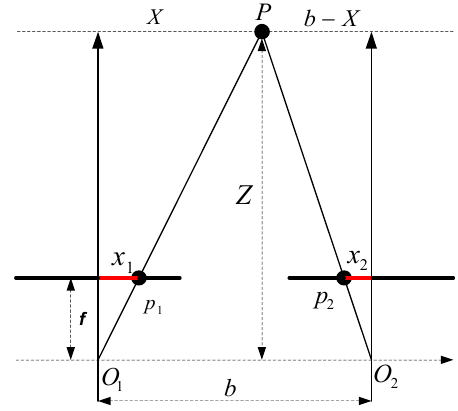
Figure 2. Triangulation scheme of stereo vision.